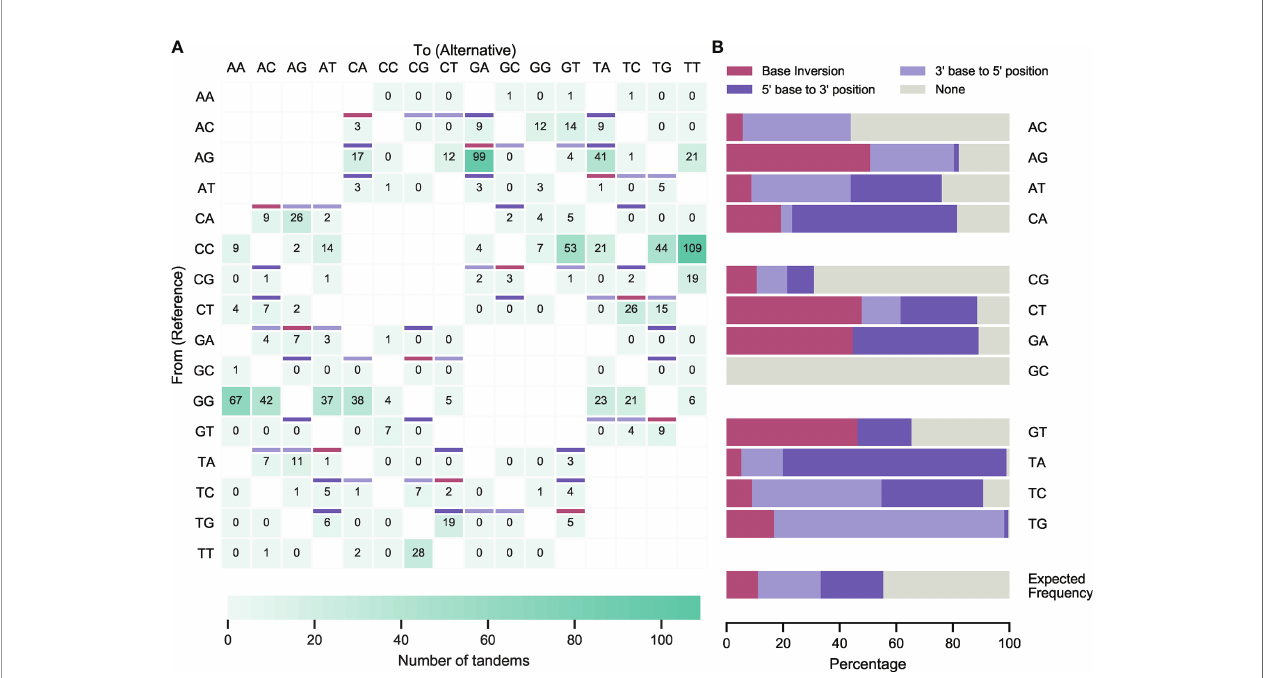
FIGURE 6 | Corrected incidence of tandem dinucleotide substitutions in MSH2/6 de fi ciency. (A) Dinucleotide substitutions from unique IGHV sequences obtained from constitutional mismatch repair de fi ciency (CMMRD) patients and corrected after in silico predictions of dinucleotide substitutions that did not occur in tandem. Burgundy cells represent sequence inversions, light and dark purple cells represent juxtalocations of the 5 ’ and 3 ’ base in the pair (as seen from the non-transcribed strand), respectively. For unshaded cells, juxtalocation could not be assessed due to one or more nucleotides in the reference sequence matching the mutated sequence. (B) Relative contribution of sequence inversions and